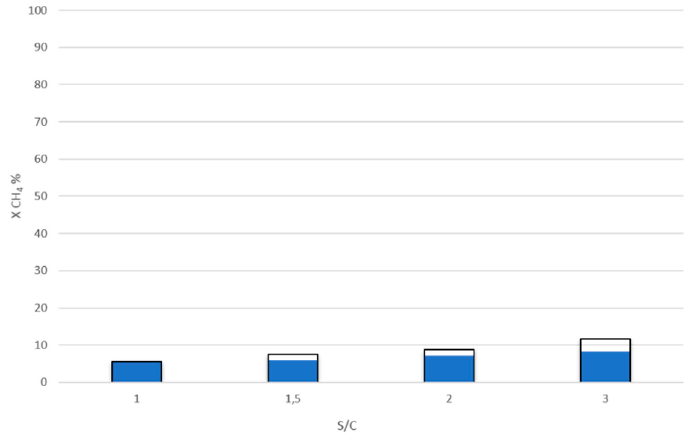
Figure 10. Comparison among tests carried out on Rh0.6-CL-R-CZOm at 30,000 h − 1 , 10 atm and 450 °C. The graph reports the methane conversion (blue) with respect to the equilibrium values (empty bars with black frames) versus different S/C ratios.